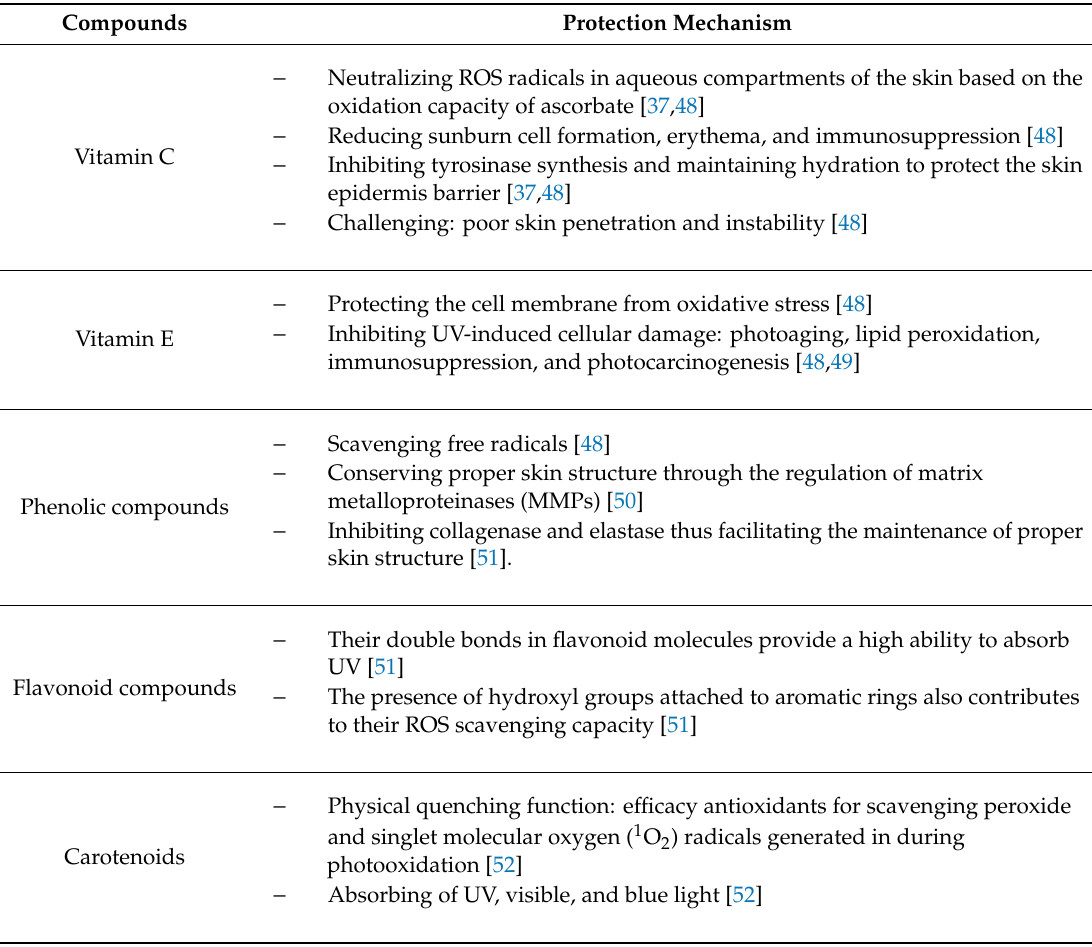
Table 1. Photoprotection mechanism of antioxidant